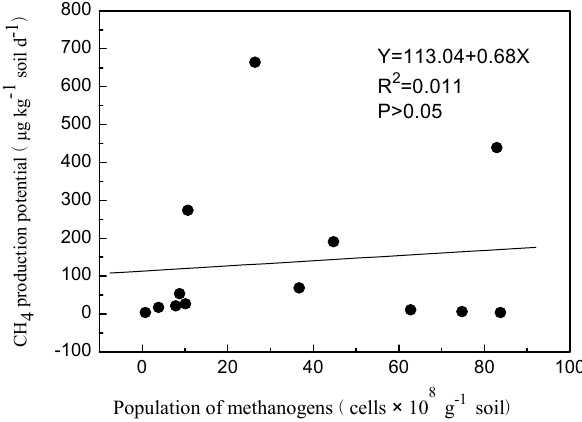
Fig. 6. Relationship between population of methanogenic archaea and mean CH 4 production potential in different soil layers of stud- ied natural wetlands across China.